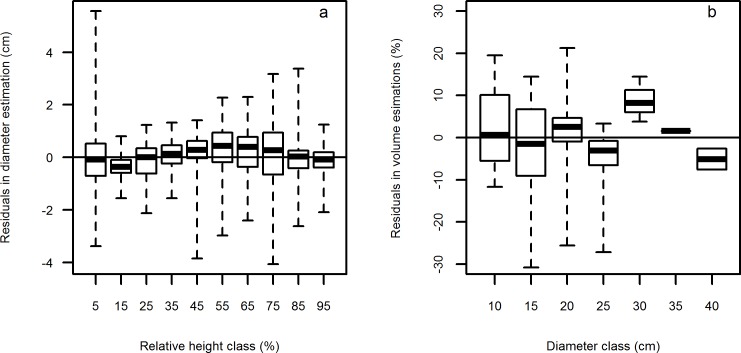
Boxplot of: (a) residuals in diameter against relative height classes and (b) residuals in volume estimation against diameter classes.The horizontal line represents 0 in residuals.